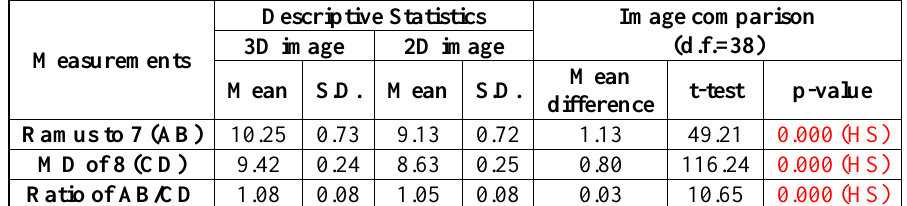
Table 3 : Descriptive statistics and image difference for the variables measured Measurements